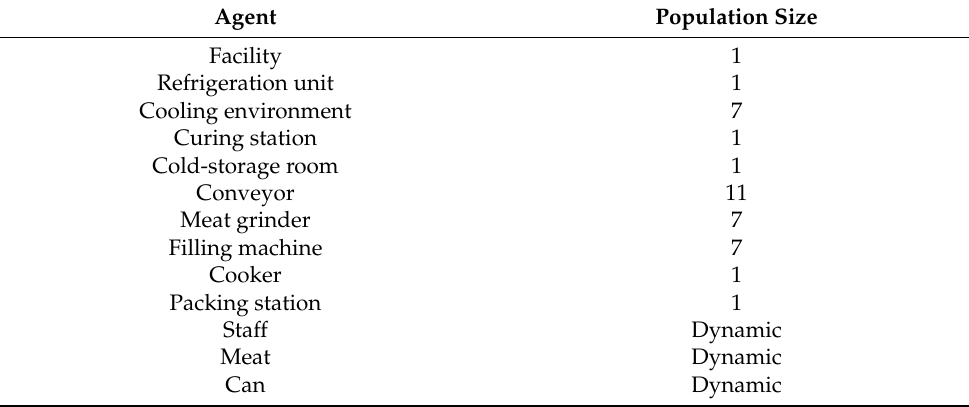
Table 6. Agent population-sizes for case study.